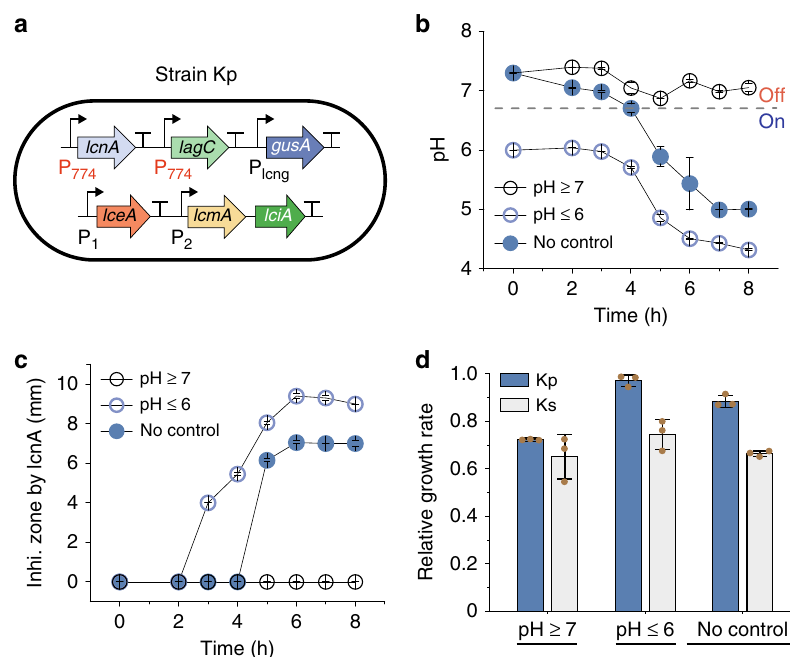
Fig. 5 A synthetic strain whose interactions vary with environmental pH. a Design of the strain Kp. The lcnA precursor gene, lcnA , is driven by the pH- dependent promoter P 774 while other lcnA biosynthesis genes lceA , lciA, and lcmA are under the control of native constitutive promoters P 1 and P 2 , leading to a pH-modulated production of lcnA. Meanwhile, lagC , the lcnG immunity gene, is regulated by the promoter P 774 , resulting in pH-dependent resistance to lcnG. Additionally, the reporter gene gusA3 was introduced to Kp to enable quanti fi cation. b , c Temporal pro fi les of extracellular pH ( b ) and the sizes of lcnA inhibition zone ( c ) of Kp in three pH-de fi ned conditions: pH ≥ 7, pH ≤ 6 and no pH control. d Relative growth rates of Kp and Ks in GM17 media mixed with the supernatant of C α -C β co-culture normalized by those growing in the media mixed with the C α -C β ’ supernatant in three pH-de fi ned conditions. Source Data available in the source data fi